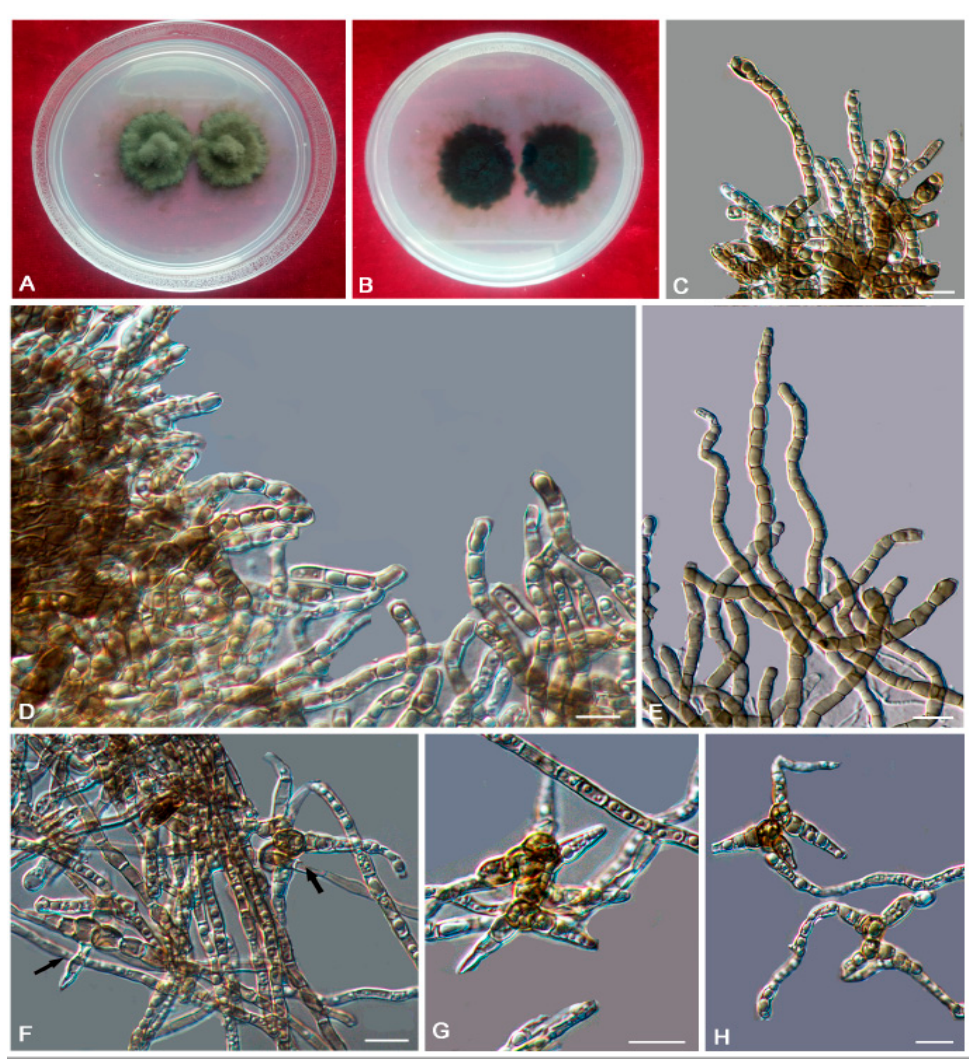
Figure 15. Trichomerium lapideum (CGMCC 3.17311). ( A , B ) Colony forward and reverse after 20 weeks on MEA. ( C – E ) Moniliform hyphae with constricted septa. ( F – H ) Branched conidia (arrows). Scale bars: ( C – H ) = 10 µ